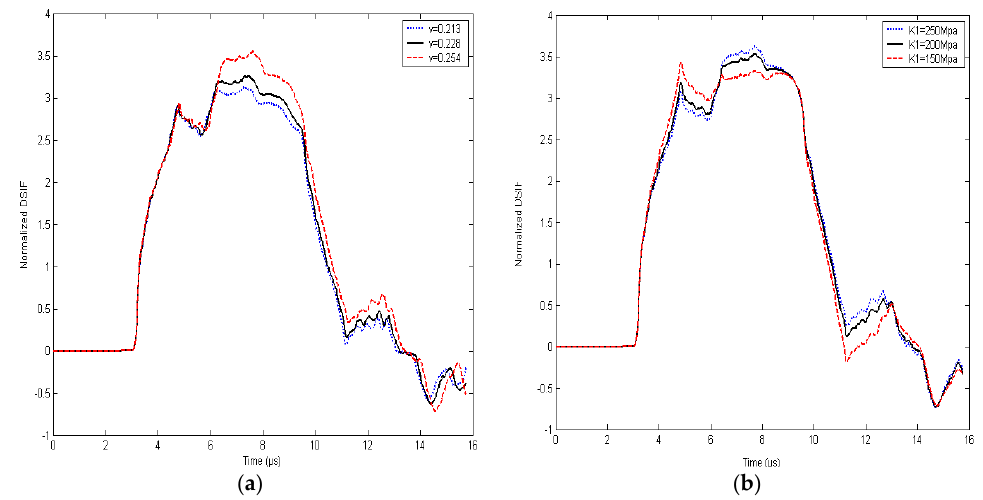
Figure 10. Normalized dynamic stress intensity factors for different Poisson coefficients ( a ); and for different K 1 ( b ).